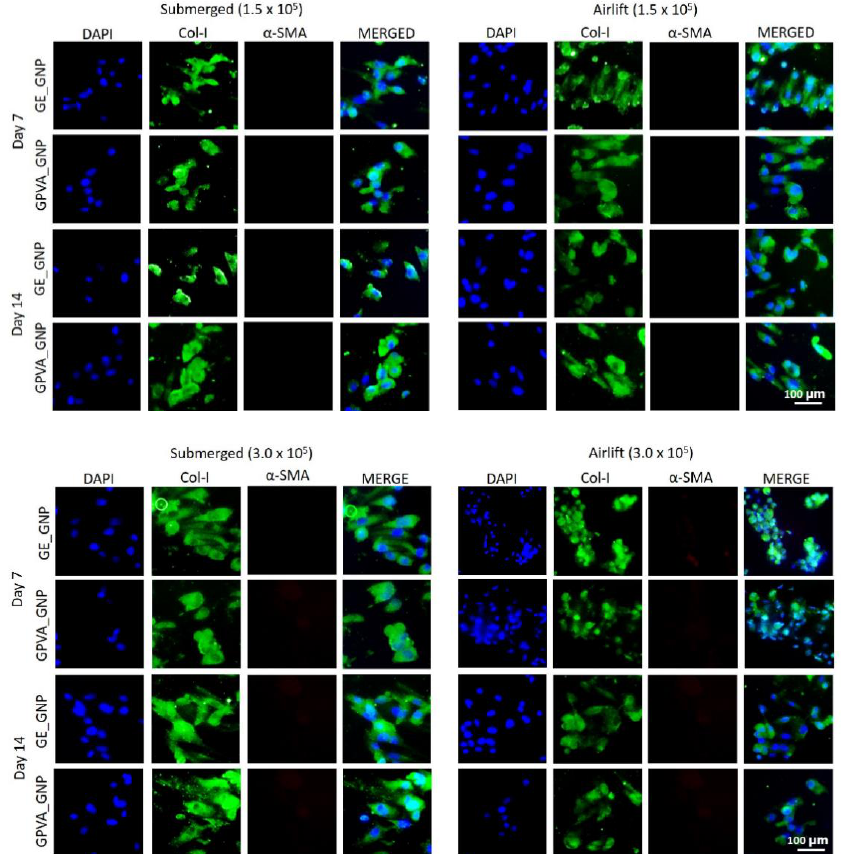
Figure 5. Fluorescence images of HDFs encapsulated in the hydrogels under different cell densities and cultivation models, on day 7 and 14. The HDFs were stained for collagen type-I (green; col-I), alpha-smooth muscle actin (red; α -SMA), and nucleus (blue; DAPI) under 20× magnification.